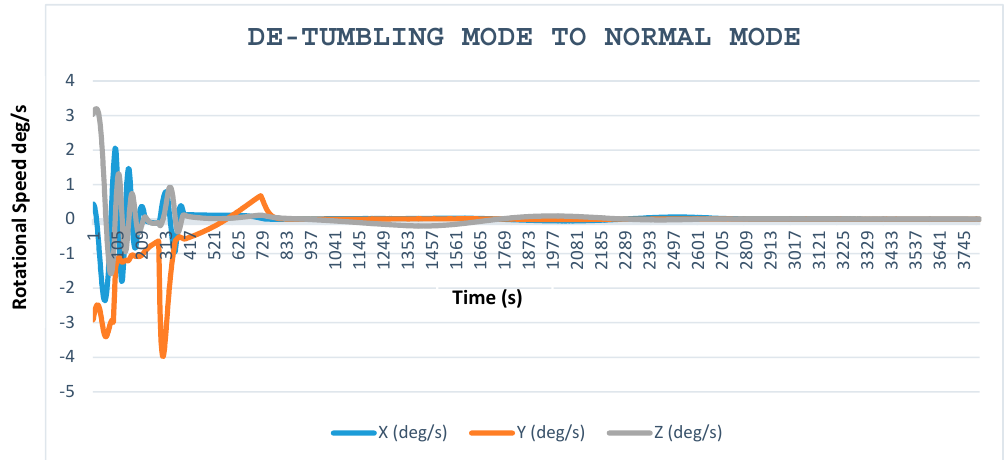
Figure 20. Results of the ADCS control using Y-Thomson controller.